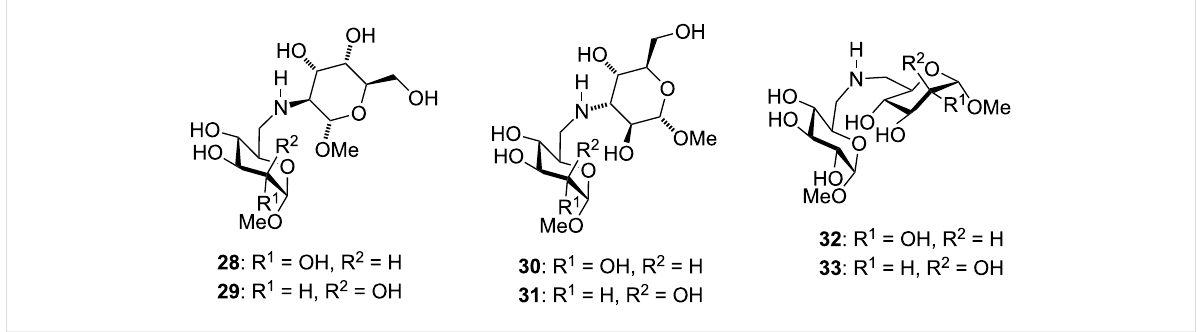
Figure 1: Previously synthesised amine-linked diglycosides.